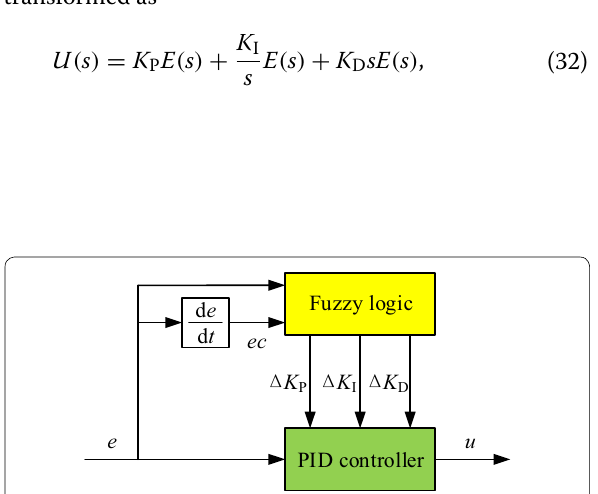
Figure 5 Schematic diagram of the fuzzy PID